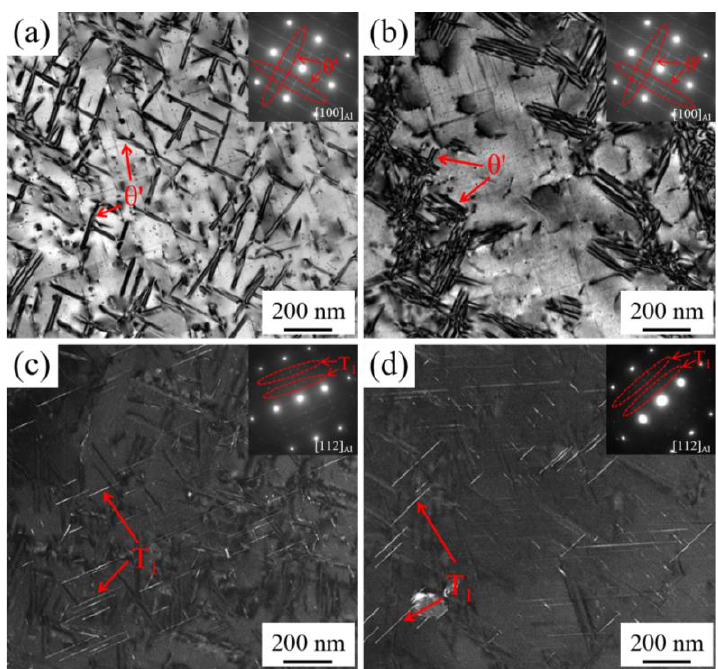
Figure 12. SAED patterns and dark field (DF) and bright field (BF) TEM images of AL2 ( a ), ( c ), and AL1 ( b ), ( d ) alloys ( a ), ( b ) θ′ precipitates (direction parallels to <100>Al); ( c ), ( d ) T 1 precipitates (direction parallels to <112>Al).